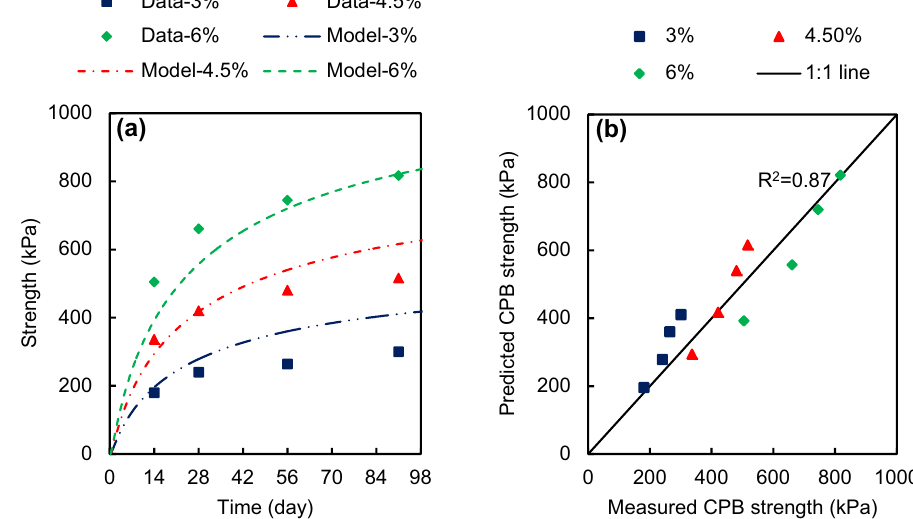
Fig. 13 Effect of cement content on long-term CPB strength: a changes to CPB strength with curing time and b correlation between predicted results and measured CPB strength